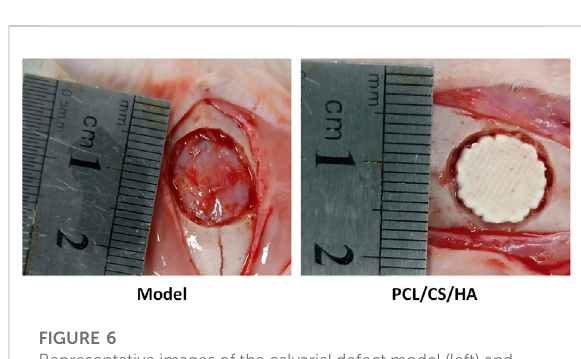
FIGURE 6 Representative images of the calvarial defect model (left) and HA/CS/PCL composite scaffold implantation